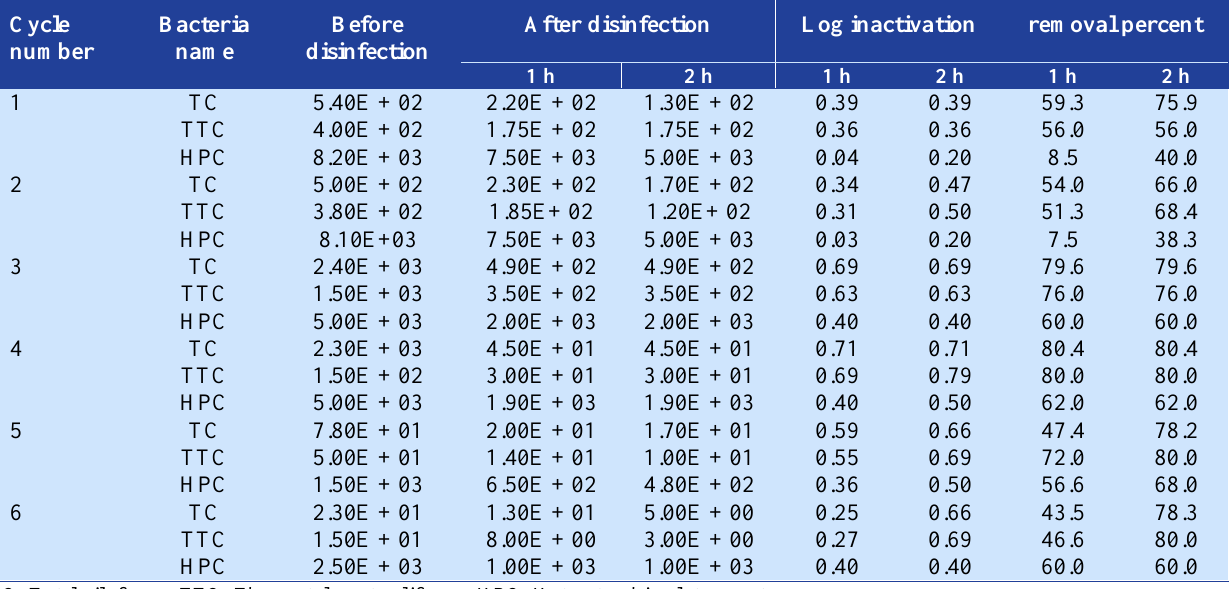
Table 2. Hydropad steam KLEAR S38 (Hydropad Co. UK)device results after 1 and 2 h contact time